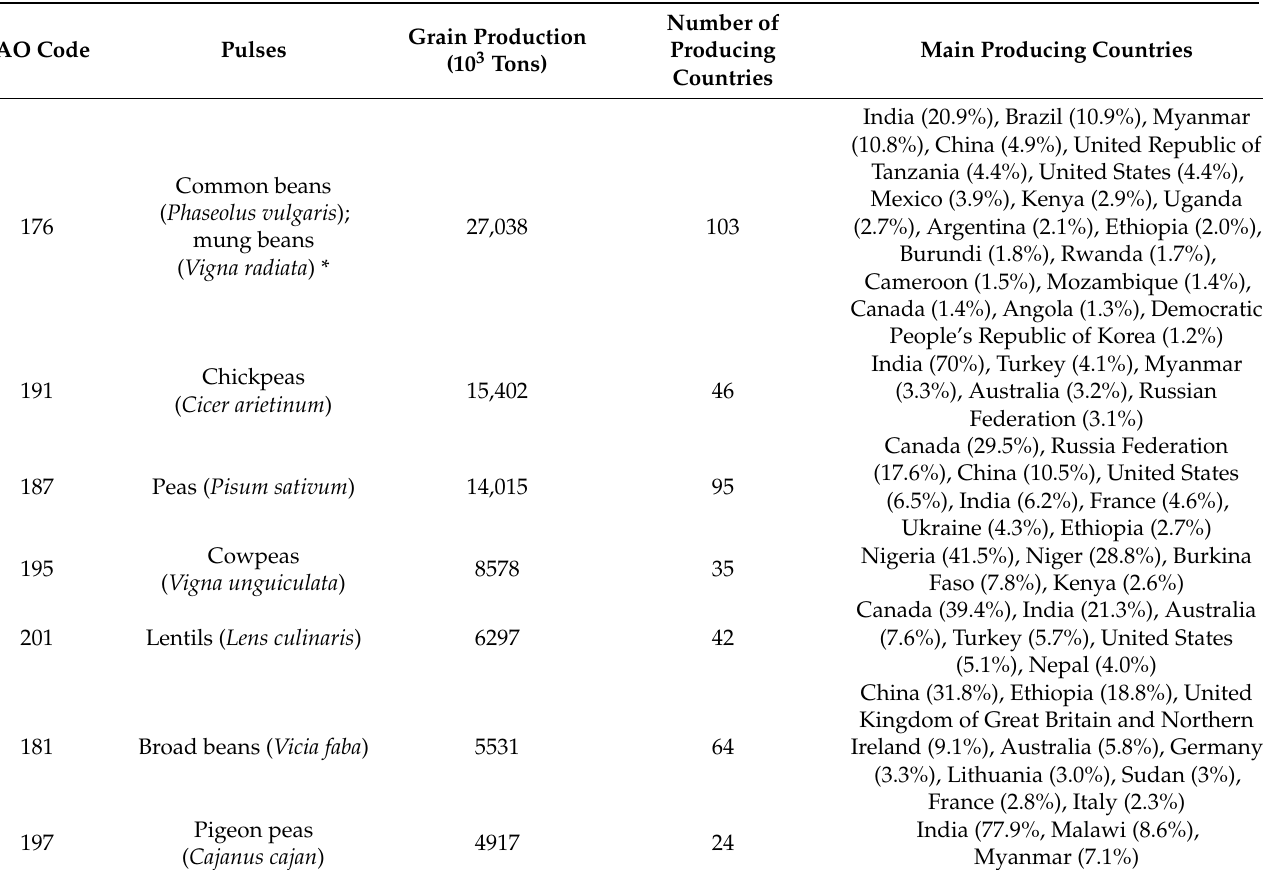
Table 1. Annual grain production of eight pulse legumes: beans, chickpeas, peas, cowpeas, mung beans, lentils, broad beans, and pigeon peas according to the FAOSTAT code. Data are averages for the period 2018 to 2020. Countries responsible for at least 80% of total production are